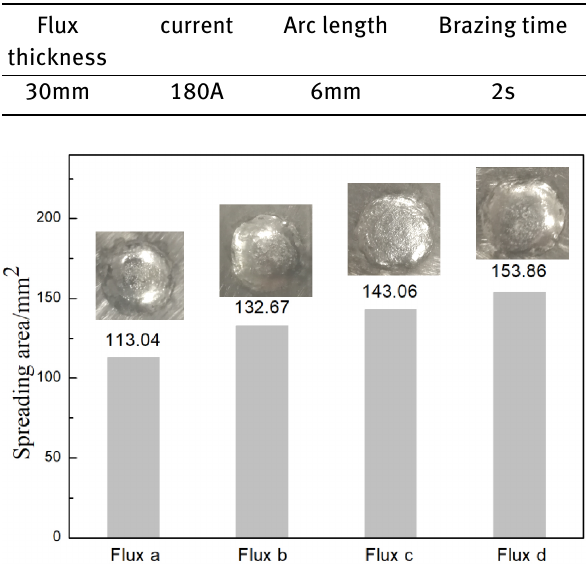
Figure 1: Spreading area of submerged arc brazing tin-based bab-